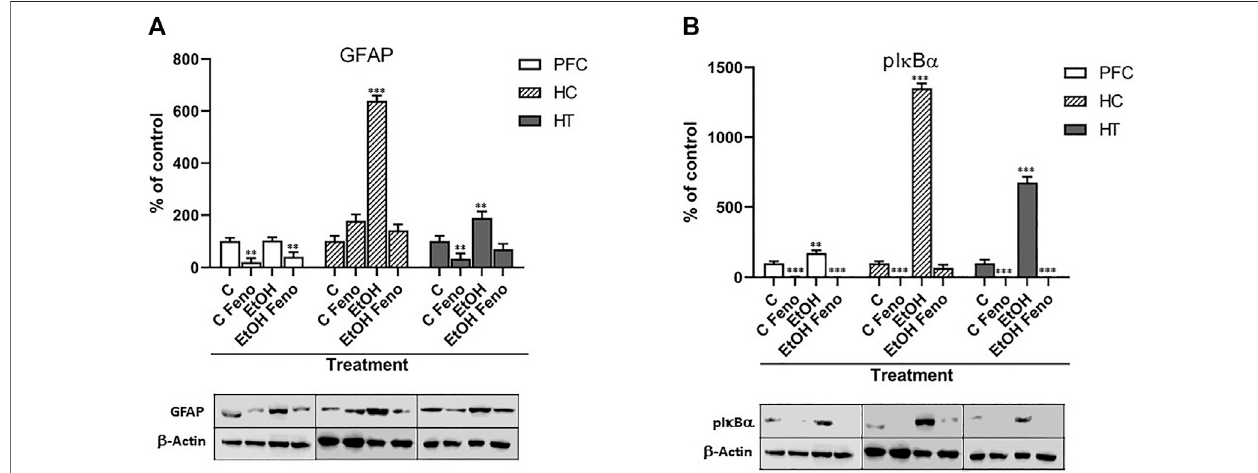
FIGURE 1 | Expression levels of GFAP (A) and pI κ B α (B) in prefrontal cortex (PFC), hippocampus (HC) and hypothalamus (HT) in rats that were administered alcohol for one month and then were treated with feno fi brate for 14 days. C (cid:1) water-administered controls; C Feno (cid:1) water-administered controls treated with feno fi brate;EtOH (cid:1) alcohol-treatedrats;EtOHFeno (cid:1) alcohol-treatedratsthentreatedwithfeno fi brate.Thegraphsshowtheproteinlevelsexpressedaspercentagesof their water-administered controls, normalized by the levels of ß -actin. Representative blots from each group are shown below each respective bar. ANOVA ** p < 0.01;*** p < 0.001.GFAPPFC:F (3,12) (cid:1) 23.50forFenoeffect;GFAPHC:F (3,12) (cid:1) 131.10forEtOHeffect;GFAPHT:F (3,12) (cid:1) 34.07forEtOHeffect,F (3,12) (cid:1) 75.40for Fenoeffect.pI κ B α PFC:F (3,12) (cid:1) 9.76forEtOHeffect,F (3,12) (cid:1) 149.90forFenoeffect;pI κ B α HC:F (3,12) (cid:1) 1,190.00forEtOHeffect,F (3,12) (cid:1) 1,314.00forFenoeffect;pI κ B α HT: F (3,12) (cid:1) 594.40for EtOH effect, F (3,12) (cid:1) 1,080.00 for Feno effect. The error bars correspondtoSD, n (cid:1) 4. Theabsolutevalues, normalized by ß -actin, obtained from thequanti fi cationofthebandsare (A) GFAP:PFC(C (cid:1) 0.98 ± 0.33;CFENO (cid:1) 0.20 ± 0.08;EtOH (cid:1) 1.00 ± 0.13;EtOHFENO (cid:1) 0.40 ± 0.09);HC(C (cid:1) 0.31 ± 0.11;CFENO (cid:1) 0.55 ± 0.03; EtOH (cid:1) 1.98 ± 0.04; EtOH FENO (cid:1) 0.44 ± 0.03); HT (C (cid:1) 0.56 ± 0.19; C FENO (cid:1) 0.19 ± 0.05; EtOH (cid:1) 1.06 ± 0.08; EtOH FENO (cid:1) 0.39 ± 0.05) (B) pI κ B α : PFC (C (cid:1) 0.35 ± 0.12; C FENO (cid:1) 0.00 ± 0.00; EtOH (cid:1) 0.60 ± 0.05; EtOH FENO (cid:1) 0.00 ± 0.00); HC (C (cid:1) 0.12 ± 0.04; C FENO (cid:1) 0.00 ± 0.00; EtOH (cid:1) 1.62 ± 0.02;